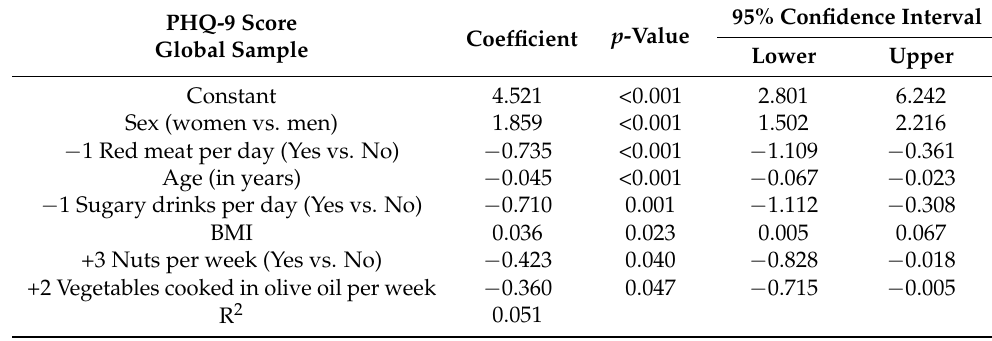
Table 3. Variant regression model of the PHQ-9 score and the variables of sex, age, educational level, BMI and MEDAS items. CCI in the individuals with chronic